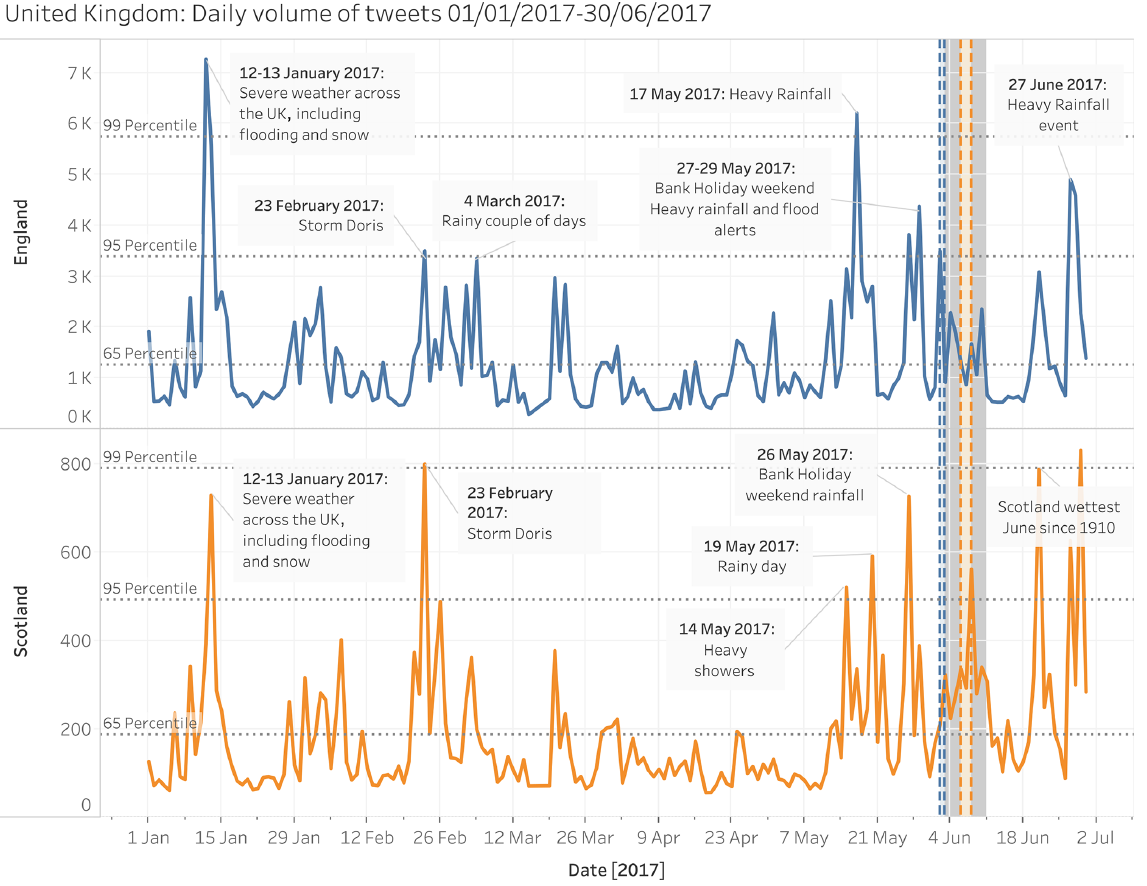
Figure 6. Time series of filtered tweets per day for each of the UK administrative areas with events in the Met Office database. The period of each heavy rainfall event in the Met Office database is shown by a shaded bar colour coded to the administrative area. The 3d after each event is shown by a grey shaded bar. Potential missed events in the Met Office database, which are identified in the Twitter data, are